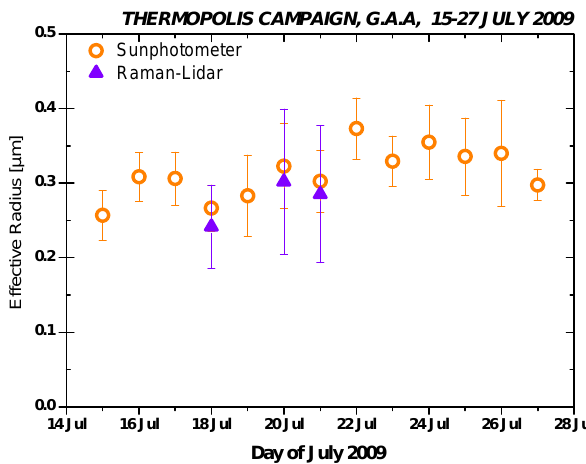
Fig. 8. Total effective radius retrieved from sun photometer and Raman lidar signal inversions.